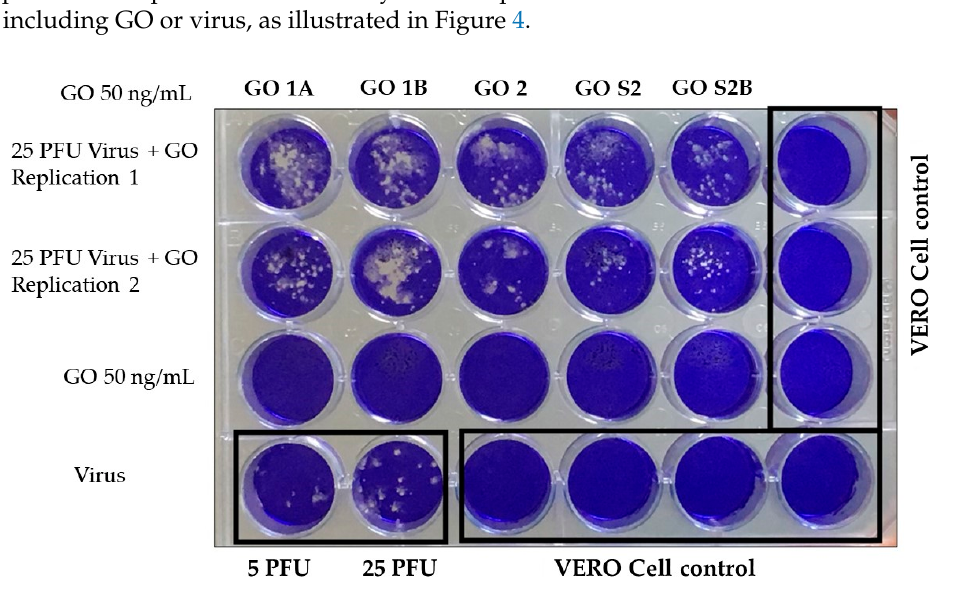
Figure 4. Assay of the antiviral activity of GO 50 ng/mL against SARS-CoV-2 in VERO cells by plat- ing. by